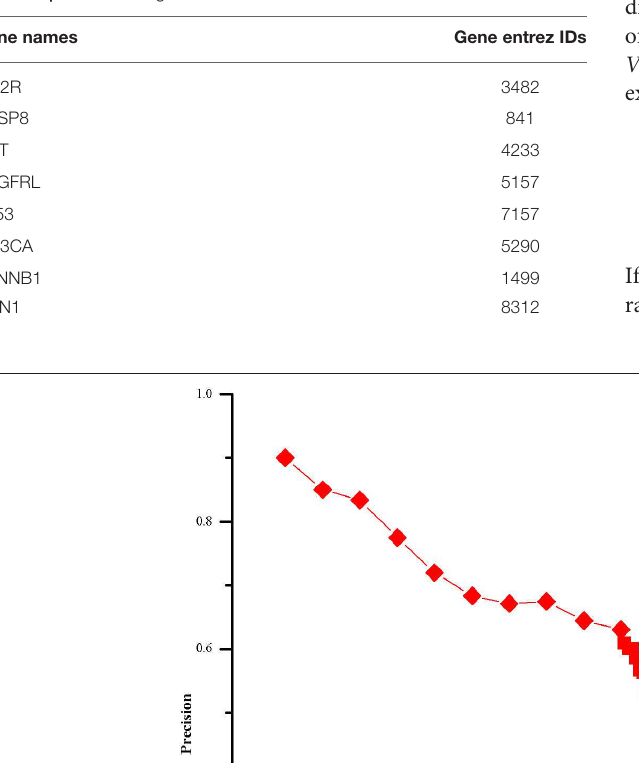
TABLE 1 | HCC related genes extracted from OMIM.